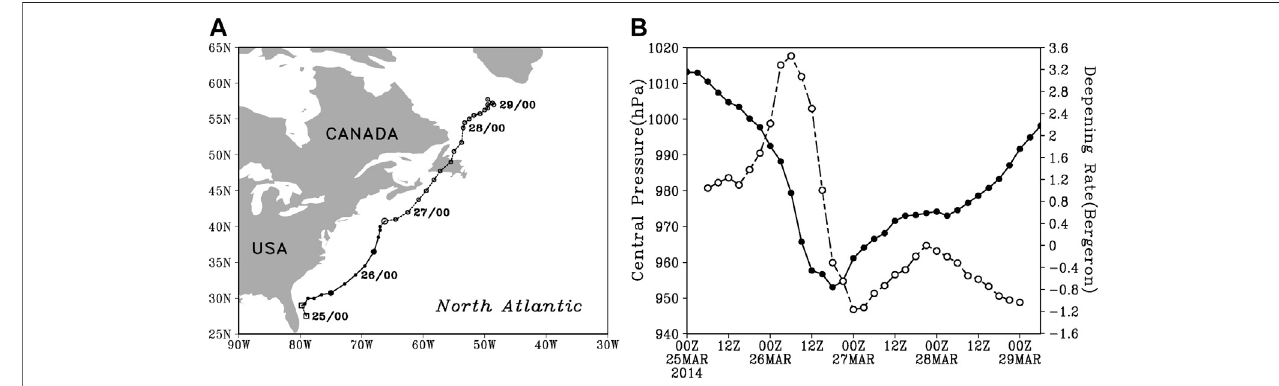
FIGURE 1 | (A) The moving track (3-h intervals), and (B) the time series of the central SLP (solid, in hPa) and deepening rate (dashed, in Bergeron). EC center is de fi ned as the minimum SLP